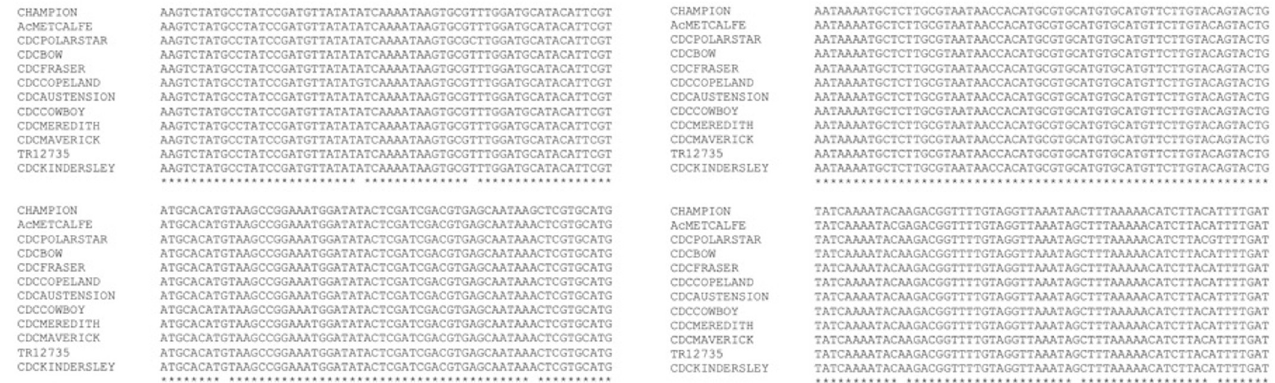
Fig 2. Multiple sequence alignment of 1000 bp downstream 3’ UTR region of HvTLP8 from different malt and feed varieties.